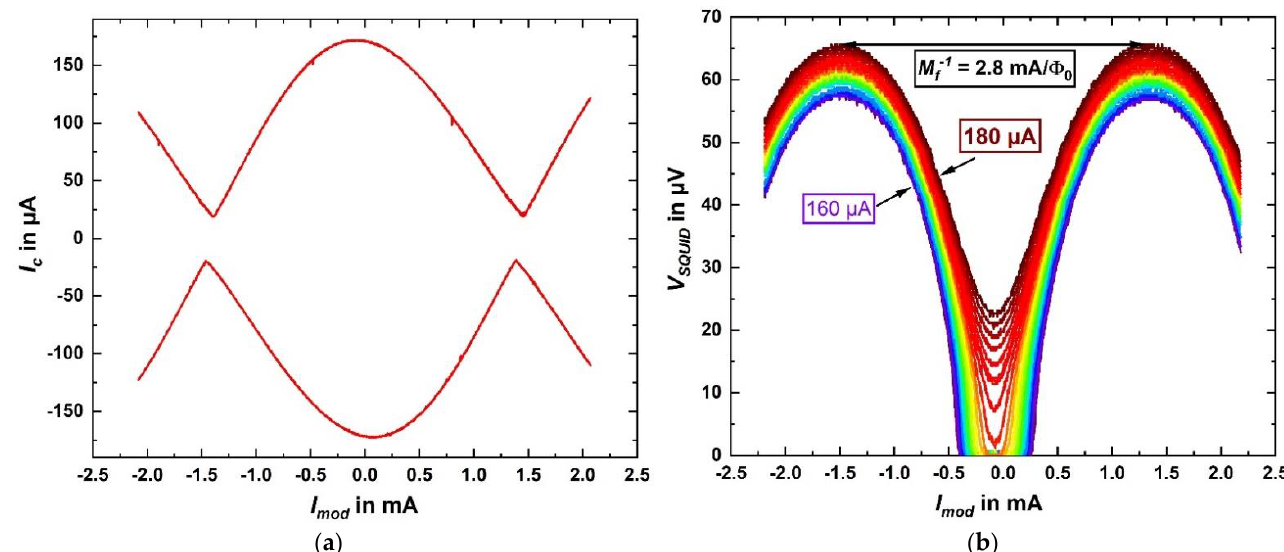
Figure 13. SQUID oscillations of SQ-2 at 4.2 K. ( a ) Critical current vs. modulation current. ( b ) Voltage vs. modulation current for constant bias currents (from 160 to 180 µA, in 1 µA steps).